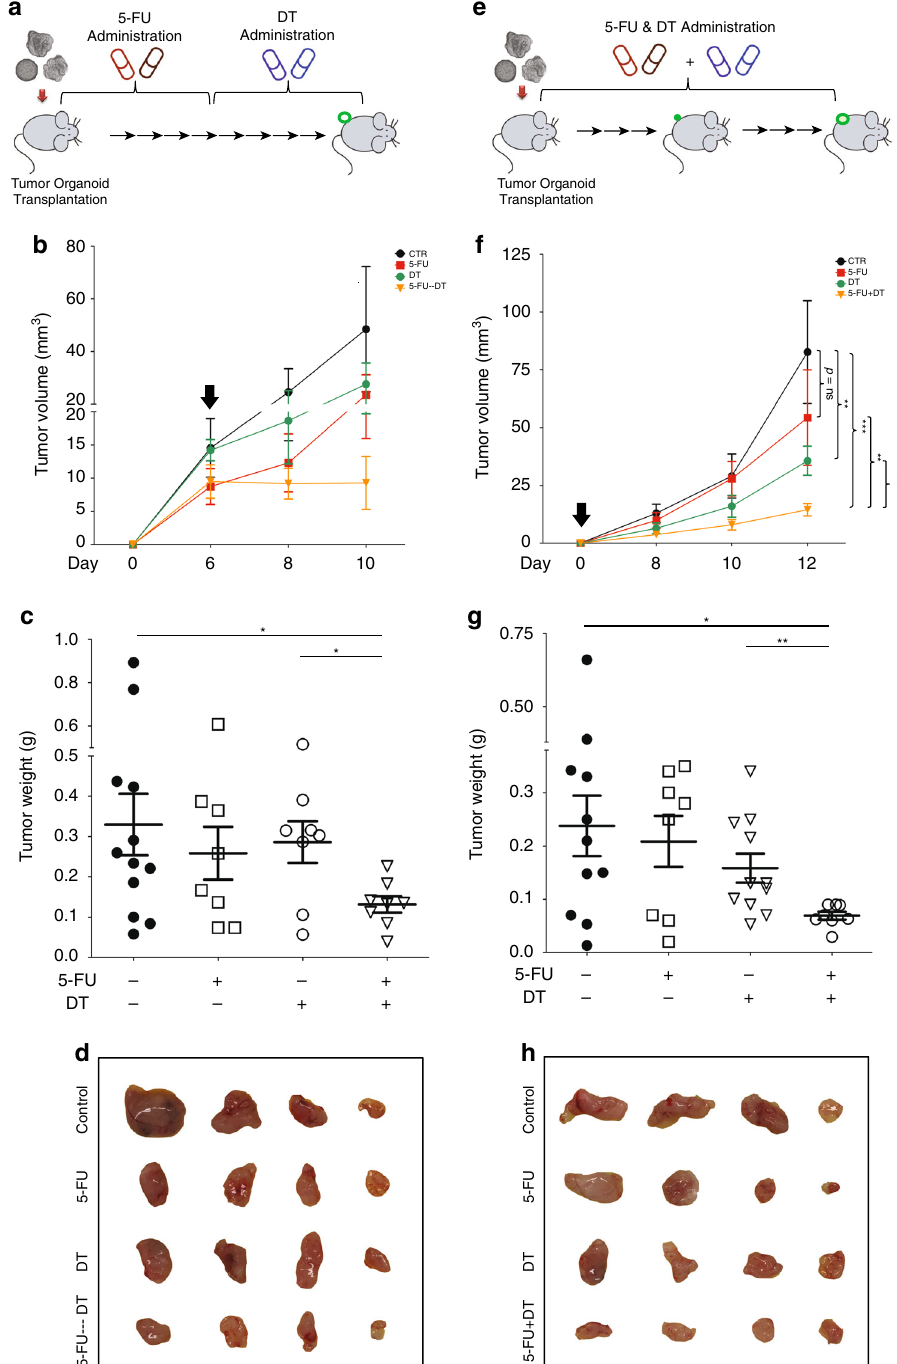
Fig. 8 Combination of LGR5 lineage ablation with 5-FU results in enhanced anticancer ef fi cacy. a Outline of the experimental strategy to assess the combinatory effect of LGR5 lineage ablation with 5-FU. Following tumor organoid allografting, 5-FU was administered for the fi rst half of the experiment (every other day, for in total 6 days). DT was administered for the second half of the experiment (every other day, for in total 6 days). b Representative growth curves showing tumor volumes in the vehicle control group (CTR), the 5-FU monotherapy group, the DT administration-only group, and the hybrid 5-FU/DT group. Black arrow: onset of DT administration. c Tumor masses from these four groups (control vs. 5-FU vs. DT vs. 5-FU-DT: 0.33 ± 0.076 g, n = 12 vs. 0.25 ± 0.066 g, n = 8 vs. 0.29 ± 0.052 g, n = 8 vs. 0.13 ± 0.020 g, n = 8). d Representative images showing tumors from these four groups. e Outlines of the experimental strategy for assessing the effects of combined LGR5 lineage ablation and 5-FU treatment. 5-FU, DT, or the combination were administered since organoid engraftment every other day, for in total 12 days. f Representative growth curves showing tumor volumes of the four groups. Black arrow: onset of administration (two-way ANOVA). g The tumor masses of these four groups (control vs. 5-FU vs. DT vs. 5-FU + DT: 0.24 ± 0.056, n = 11 vs. 0.21 ± 0.048 g, n = 8 vs. 0.16 ± 0.027 g, n = 11 vs. 0.069 ± 0.007 g, n = 8). h Representative images showing the tumors from the different groups. Mean ± SEM. Source data are provided as a Source Data fi